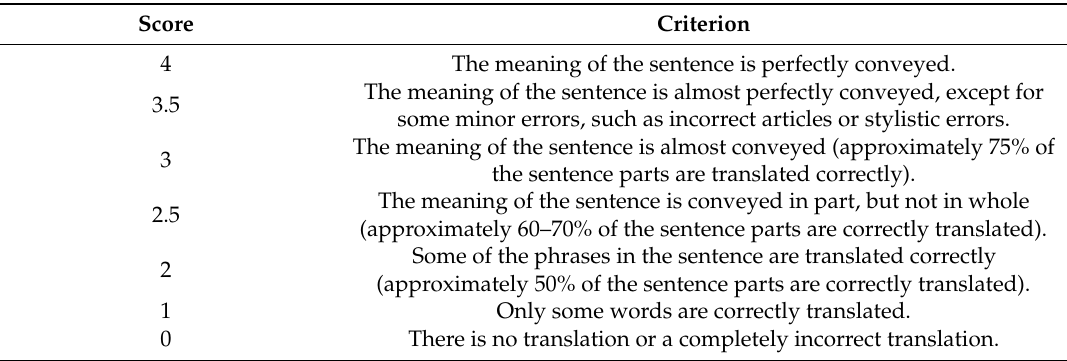
Table 2. Scoring criteria for translation